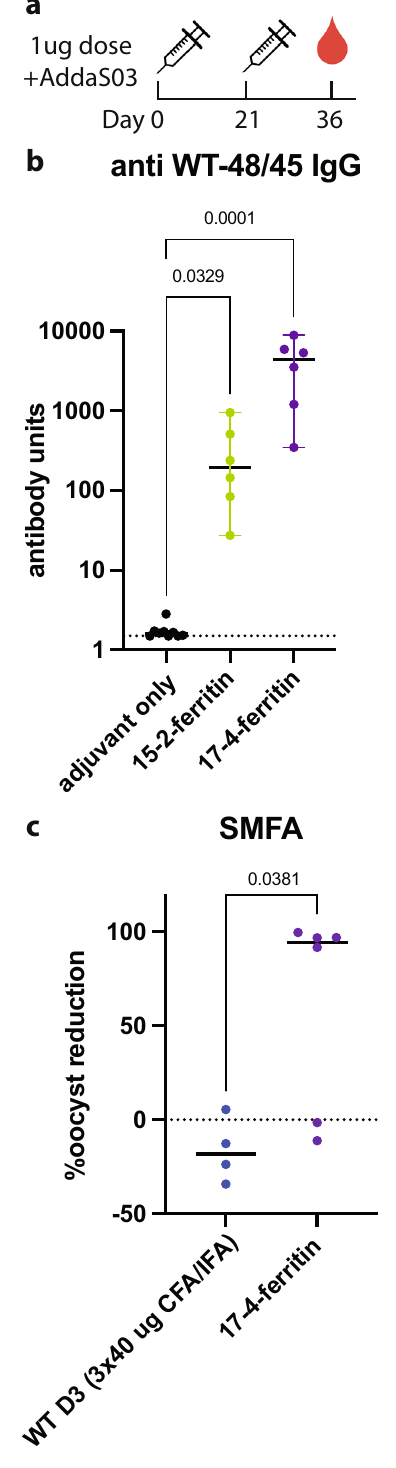
expression (Supplementary Fig. 7). A single puri fi cation step using size-exclusion chromatography yielded pure fusion protein that eluted at a size consistent with the formation of a 24-copy nanoparticle (Fig. 3c, d). Negative-stain electron microscopy images revealed pure nanoparticles and the 2D class averages showed visible antigen displayed on the exterior (Fig. 3e). In summary, antigen optimization resulted in 24-copy single-component